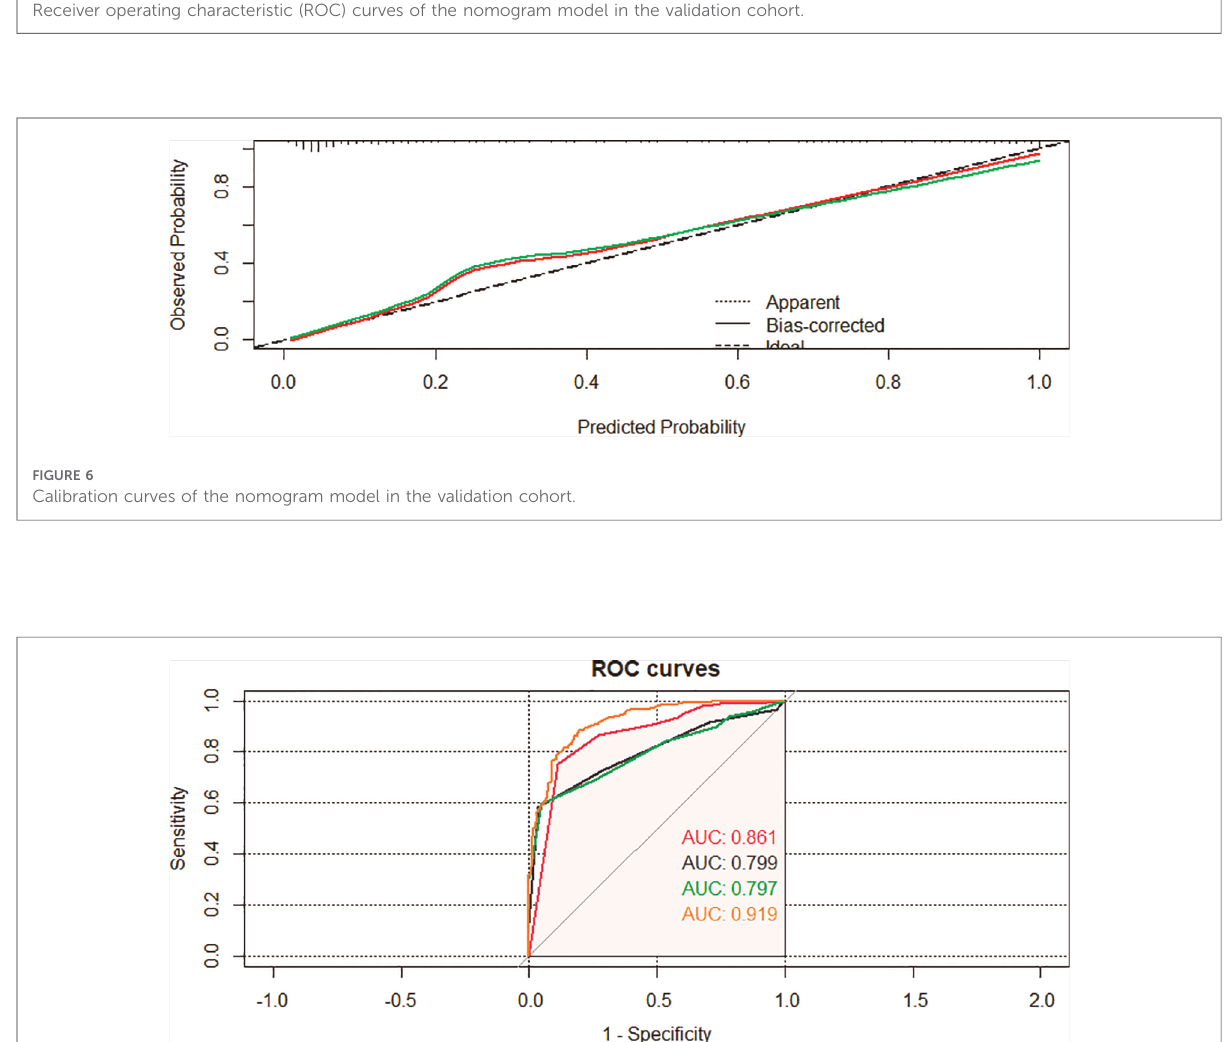
FIGURE 5 Receiver operating characteristic (ROC) curves of the nomogram model in the validation cohort.